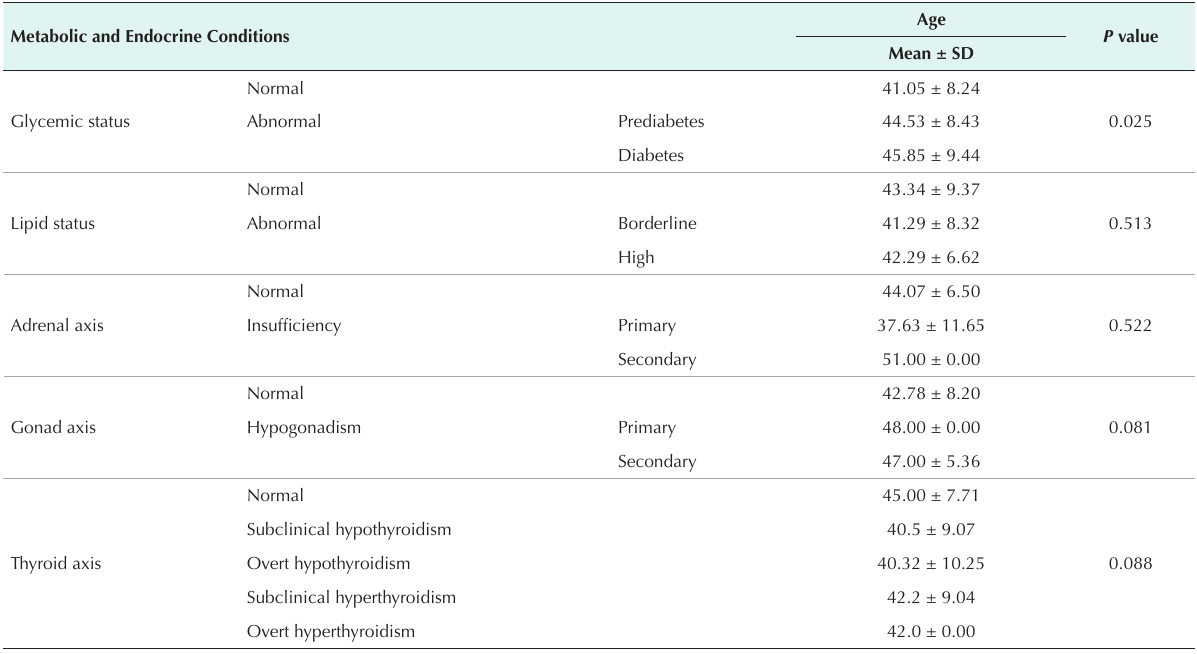
Table 3. Metabolic and Endocrine Disorders by Age in HIV-Positive Patients Metabolic and Endocrine Conditions